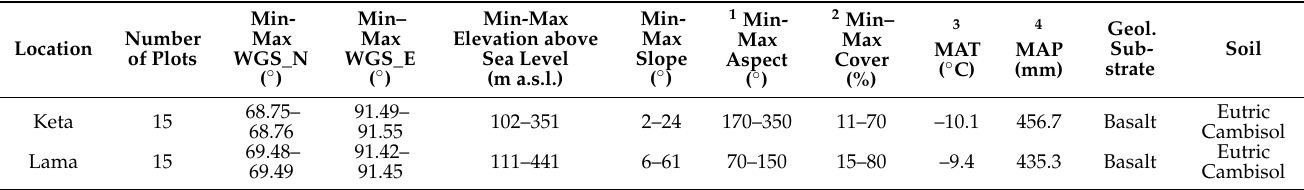
Table 6. Basic characteristics of sample plots. Mean annual temperature (MAT) and mean annual precipitation total (MAP) were calculated from the Version 4 of the CRU TS Monthly High-Resolution Gridded Multivariate Climate Dataset [91].